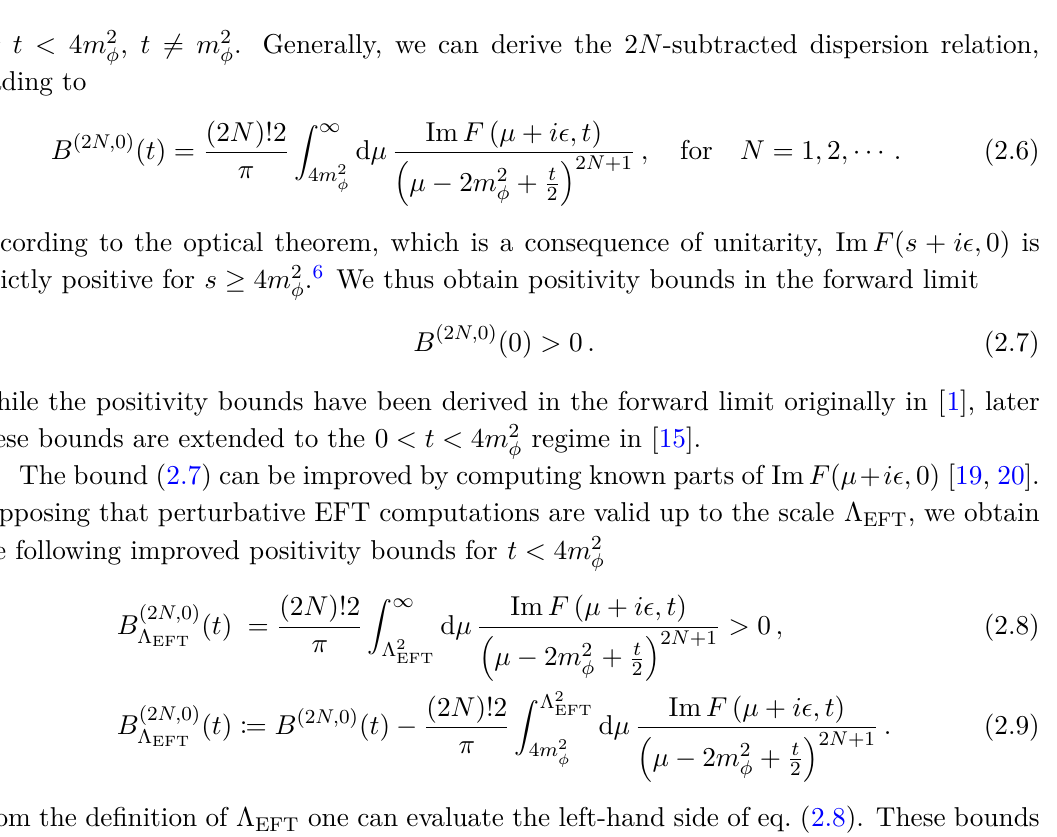
Figure 1 . Analytic structure of F ( s, t ) in the complex s -plane and the integration contours. The light-blue “ × ” and the wavy lines are simple poles associated with a stable particle φ and branch cuts generated by loops, respectively. The integration contour C can be deformed into the one on the right panel, leading to the dispersion relation